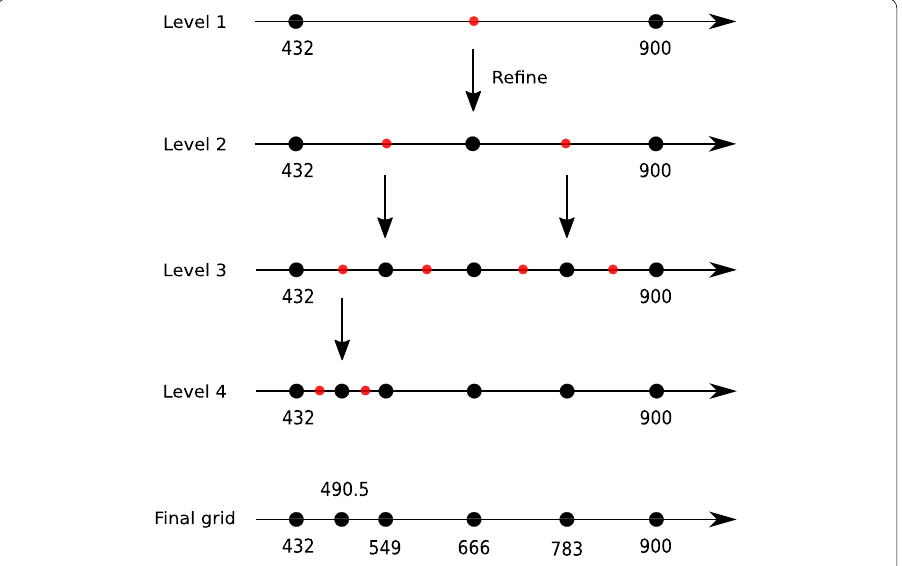
4D ⊗ 1D thermal computational vademecum